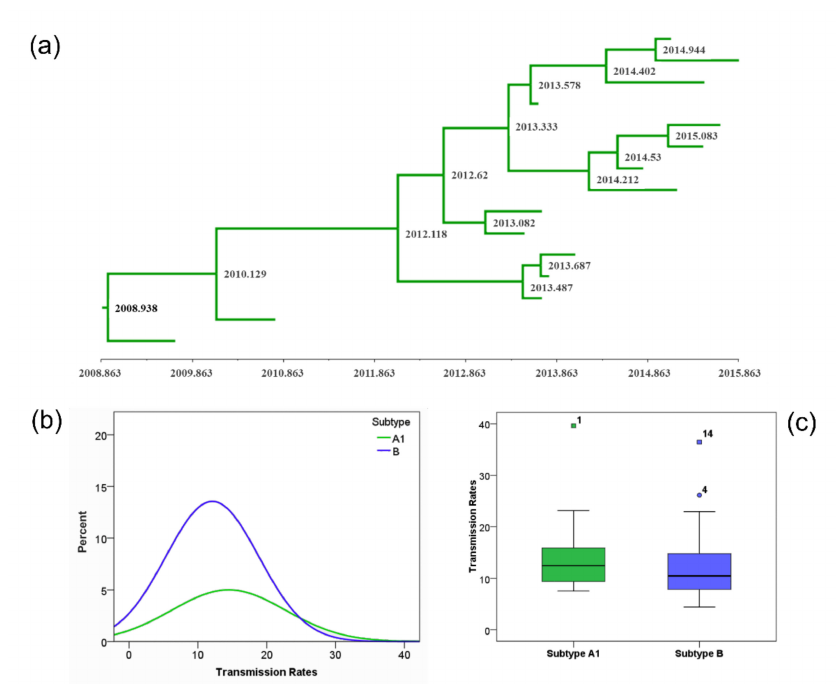
Figure 3. ( a ) Dated tree of the more recent molecular transmission cluster of subtype A1 (cluster 1), estimated by molecular clock analysis; ( b ) Distribution of transmission rates for the subtype A1 and B molecular transmission clusters; ( c ) Boxplots of transmission rates for subtype A1 and B molecular transmission